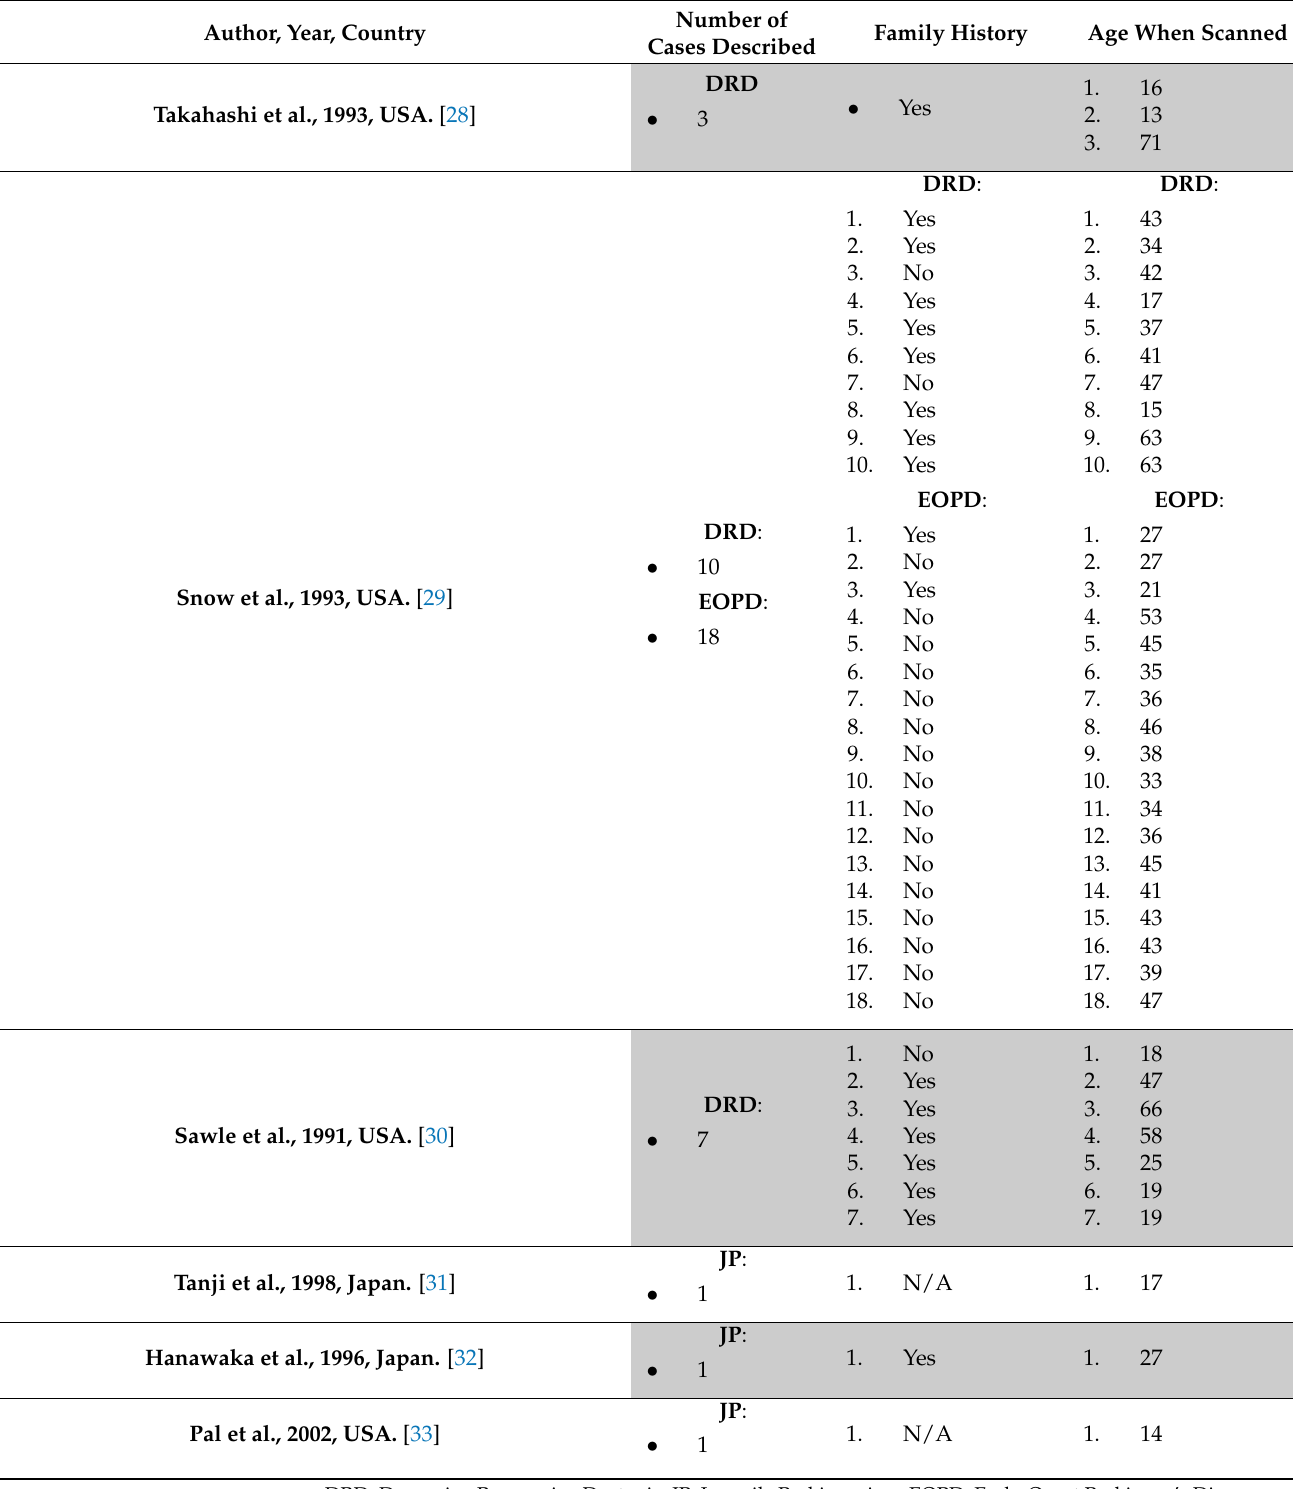
Table 3. Description and age when scanned of the Case